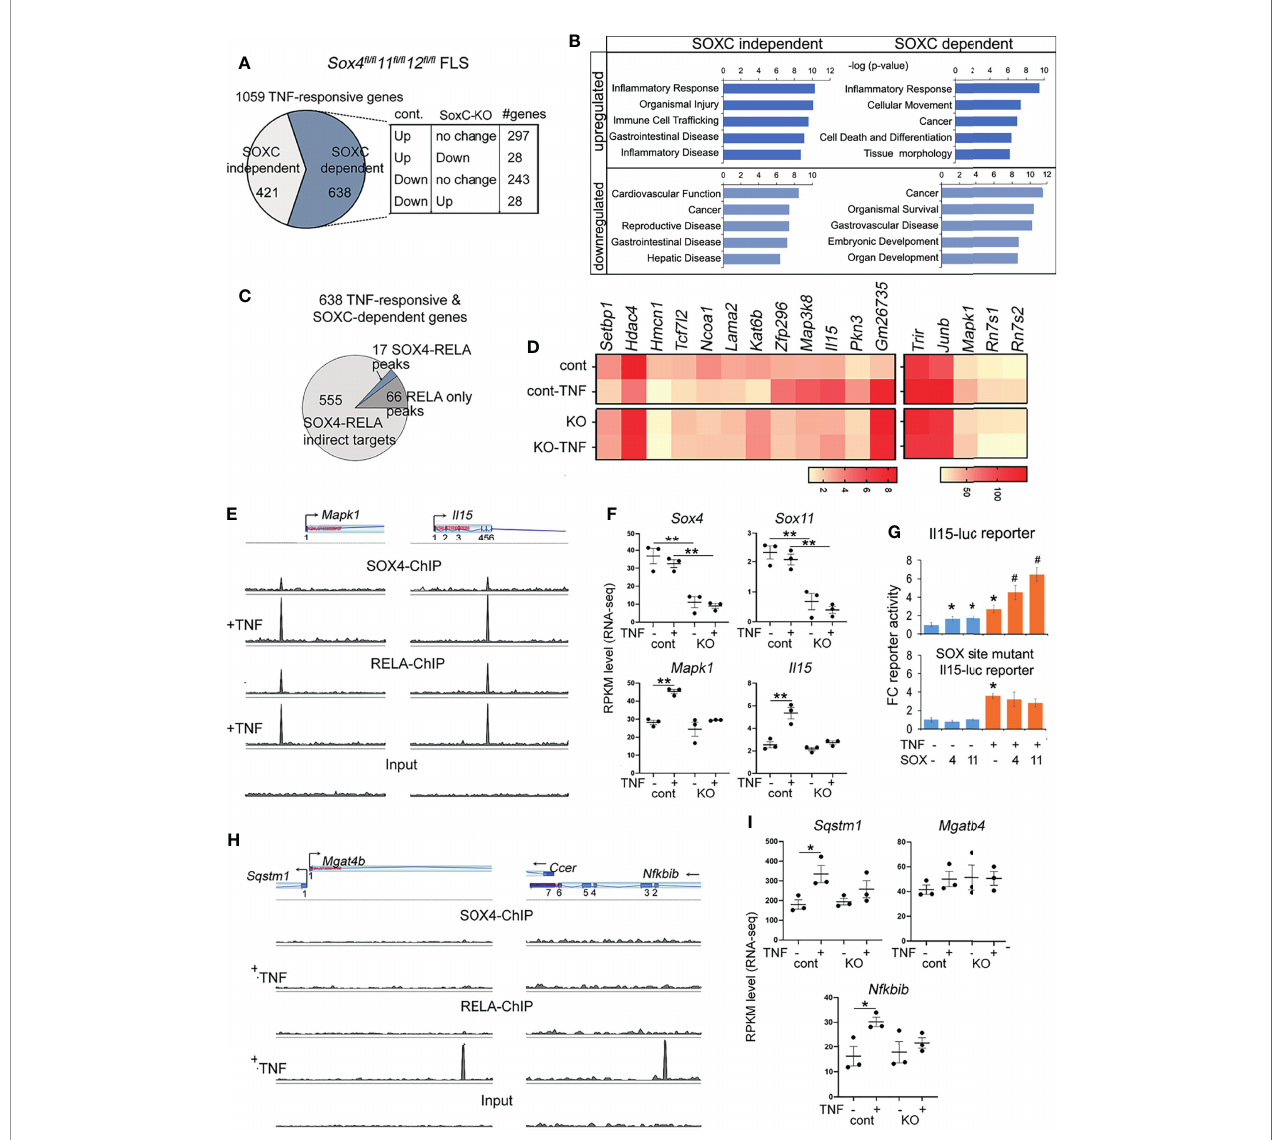
FIGURE 2 | Characterization of SOXC-dependent TNF-responsive genes. (A) Pie-chart showing the proportion of SOXC-dependent and SOXC-independent TNF- responsive genes identi fi ed from RNA-seq TNF-treated control and SoxC-KO FLS. Cont, Sox4 flfl 11 flfl 12 flfl FLS infected with GFP adenovirus. SoxC-KO, Sox4 flfl 11 flfl 12 flfl FLS infected with GFP adenovirus. The number genes upregulated, downregulated or unchanged by TNF treatment of control and SoxC-KO FLS are indicated in the box. (B) IPA pathway analysis of SOXC-dependent and independent TNF-responsive genes. (C) Pie chart showing the number of SOX4-RELA co- binding and RELA only bound genes among the SOXC-dependent TNF-responsive genes. (D) Heatmap of averaged and normalized RPKM values from RNA-seq of control and SoxC-KO FLS. (E, H) Genomic pro fi les of SOX4 and RELA ChIP-seq peaks. (F, I) Gene expression changes by RNA-seq in control and SoxC-KO FLS upon TNF treatment. (G) Fold-change Il15 and SOX-site mutated Il15 luciferase reporter activity in HEK293 cells transfected with SOX4 or SOX11 expression plasmids and treated with 10ng/mL TNF for 16h. *p-value < 0.05, **p-value < 0.001 by student ’ s t-test compared to untreated condition. #p-value < 0.05 by student ’ s t-test compared to SOX4 or SOX11 only